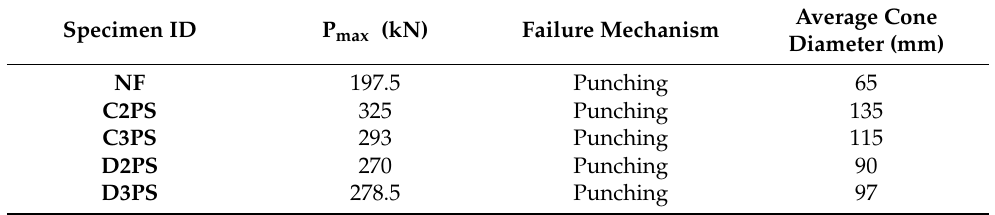
Table 3. Average cone diameter and failure type for all tested